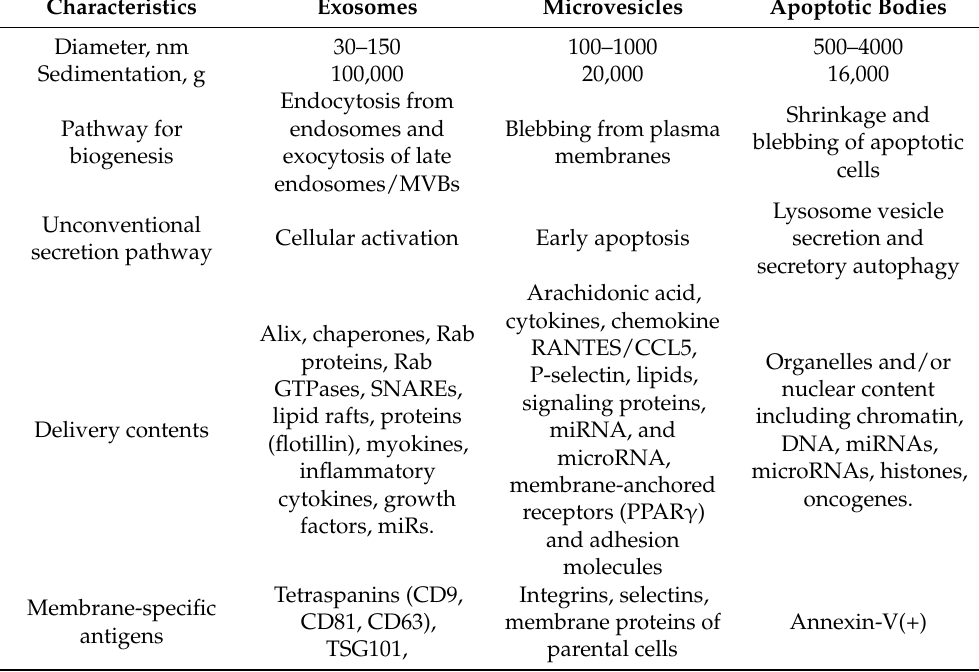
Table 1. Characteristics of